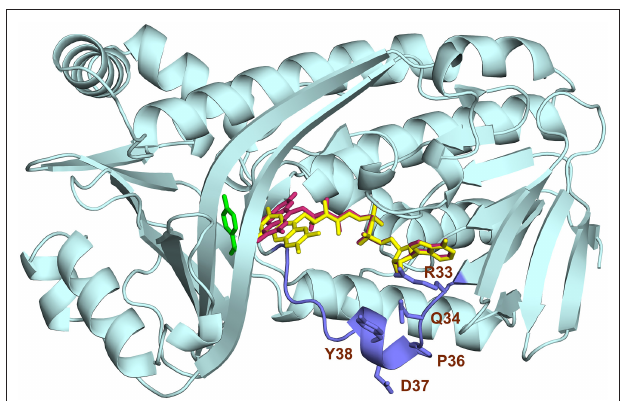
FIGURE 1 | Flavin mobility in p -hydroxybenzoate hydroxylase. Cartoon image of the crystal structure of PHBH Pf with the FAD cofactor in the in (red; pdb entry 1pbe) and out (yellow; pdb entry 1pdh) conformation. The substrate is colored green and the region containing helix H2 is colored blue. The indicated amino acids in the helix H2 region have been replaced by site-directed mutagenesis to alter the pyridine nucleotide coenzyme specificity (Eppink et al.,